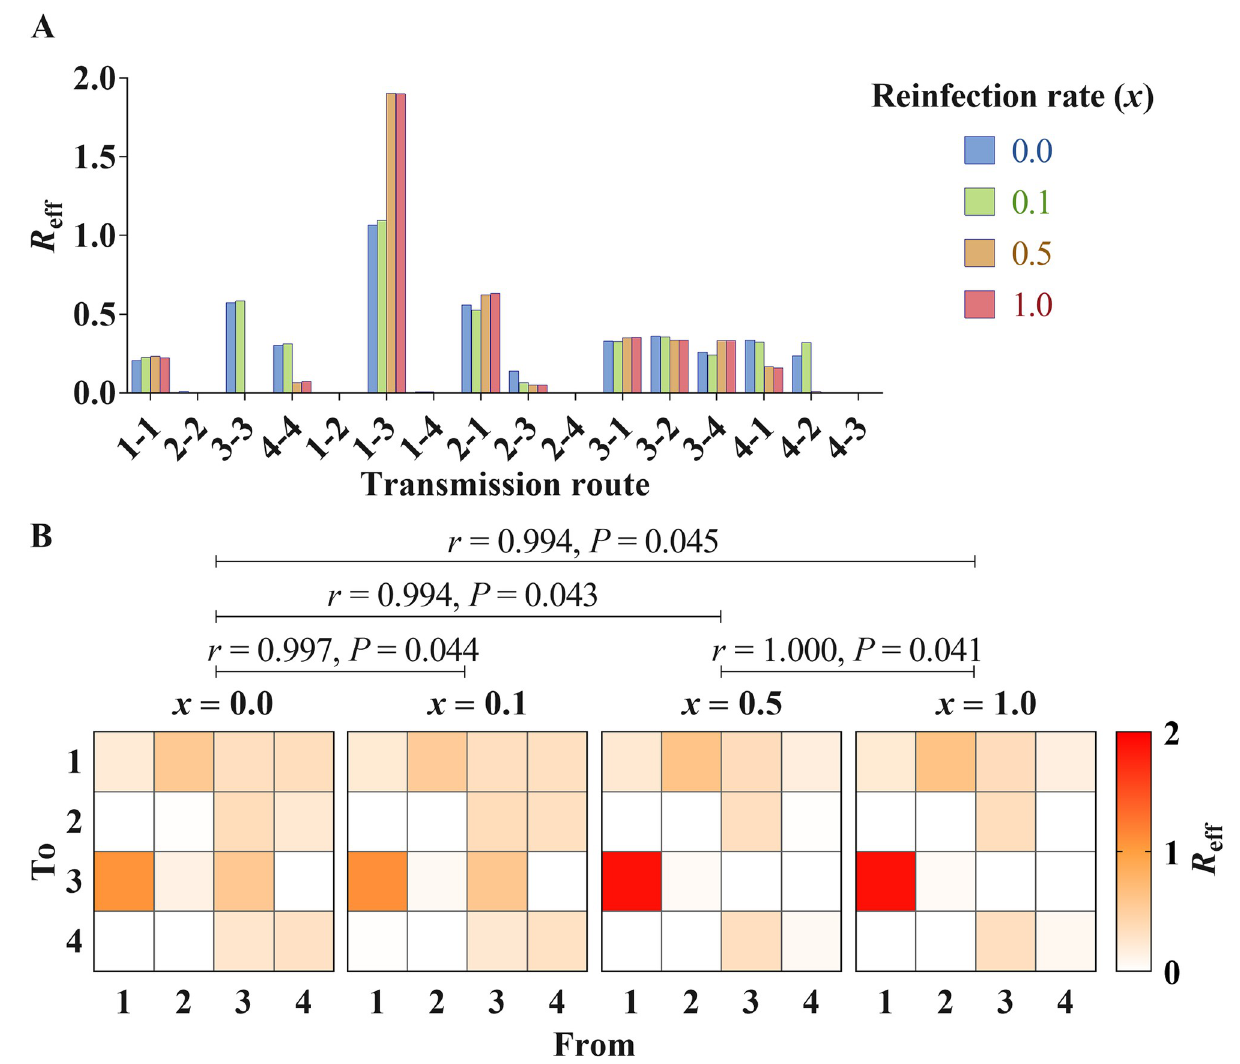
Fig 10. The influence analysis of reinfection of shigellosis in 2005. A) The different R eff values from re-calibrating curve when setting x to 0.0, 0.1, 0.5 and 1.0, respectively; 1 to 4 represent age group � 5 years old, 6–24 years old, 25–59 years old, and � 60 years old, respectively. B) Mantel statistic r ( r ) and P value from Mantel Test of two matrices; matrix means transmission from one age group to